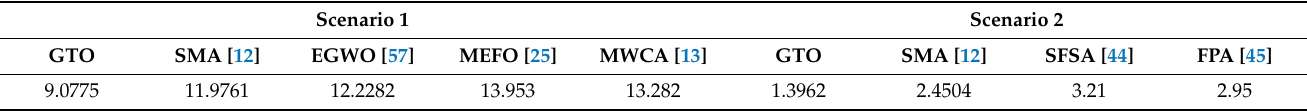
Table 4. GTO TOT comparison with other algorithms of the IEEE